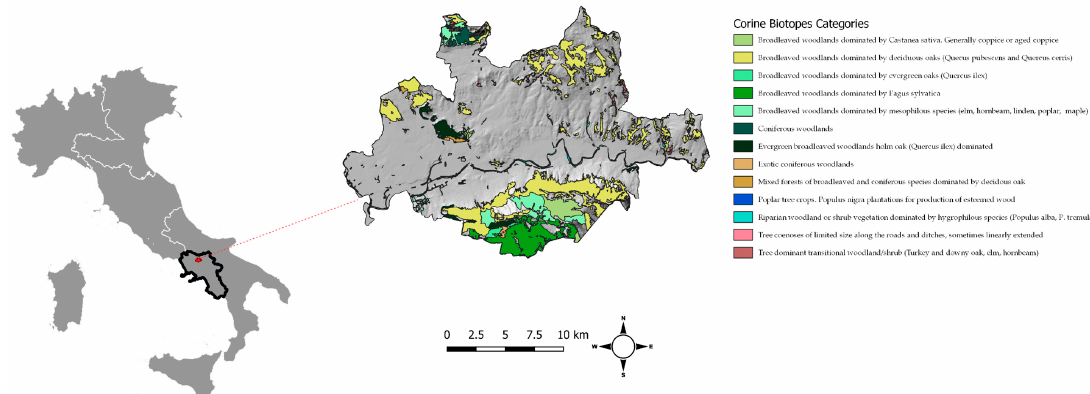
Figure 1. The study area is the Telesina Valley and it’s located in Benevento Province, in Campania Region,